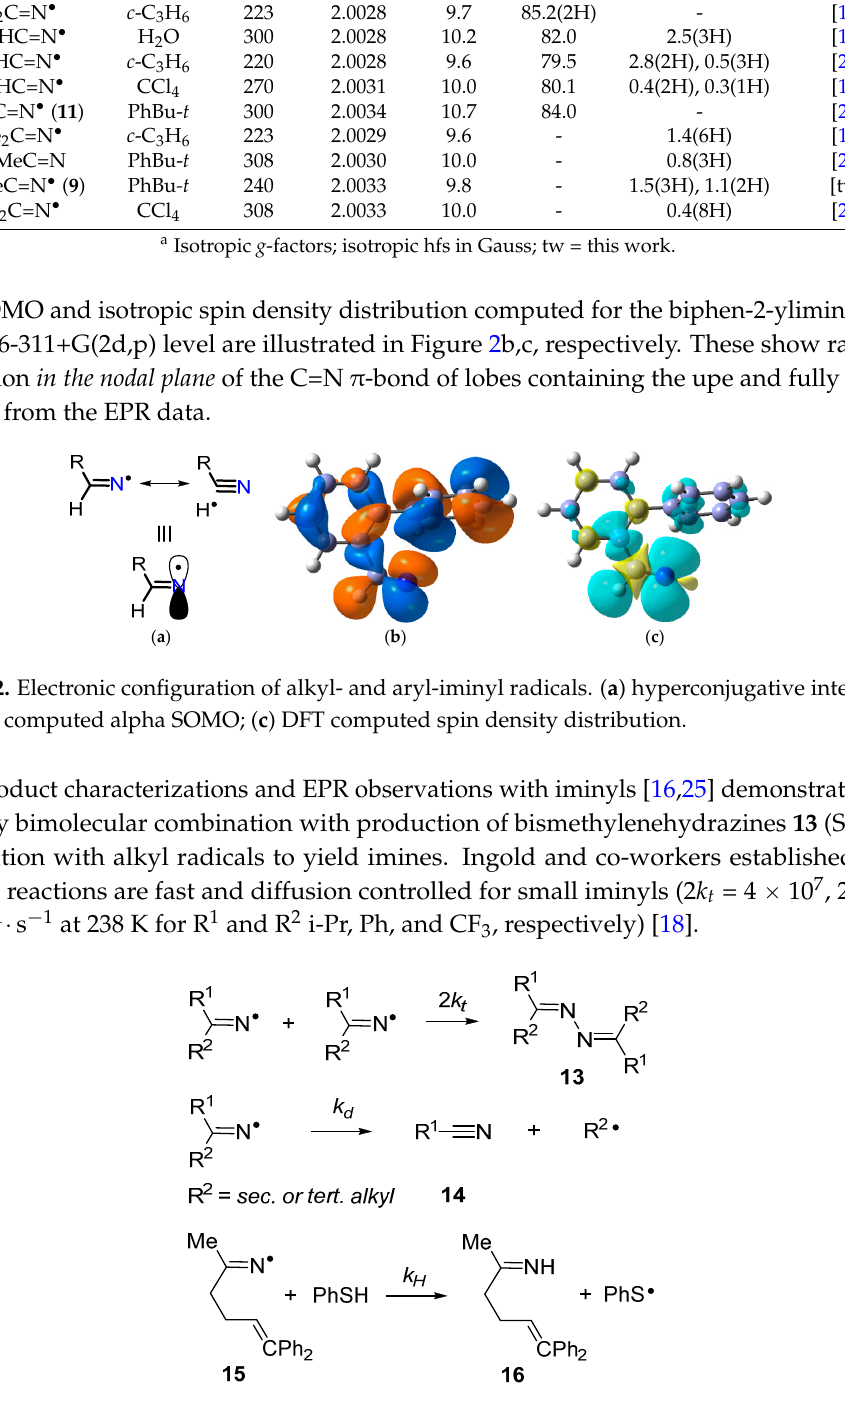
Table 1. EPR Characteristics of iminyl radicals in solution a .